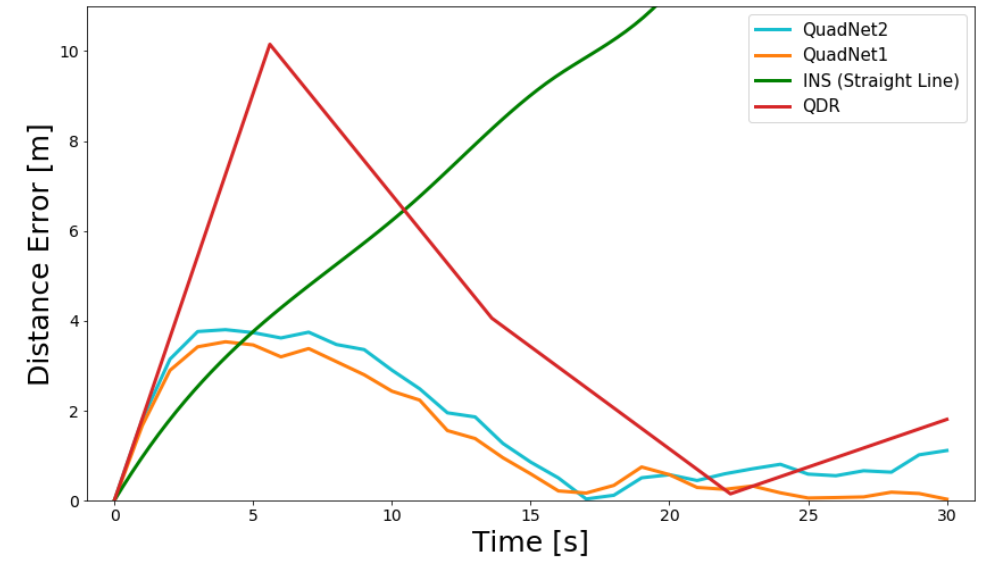
Figure 9. INS, QDR, and QuadNet architectures distance error throughout the periodic motion trajectory #2 using IMU